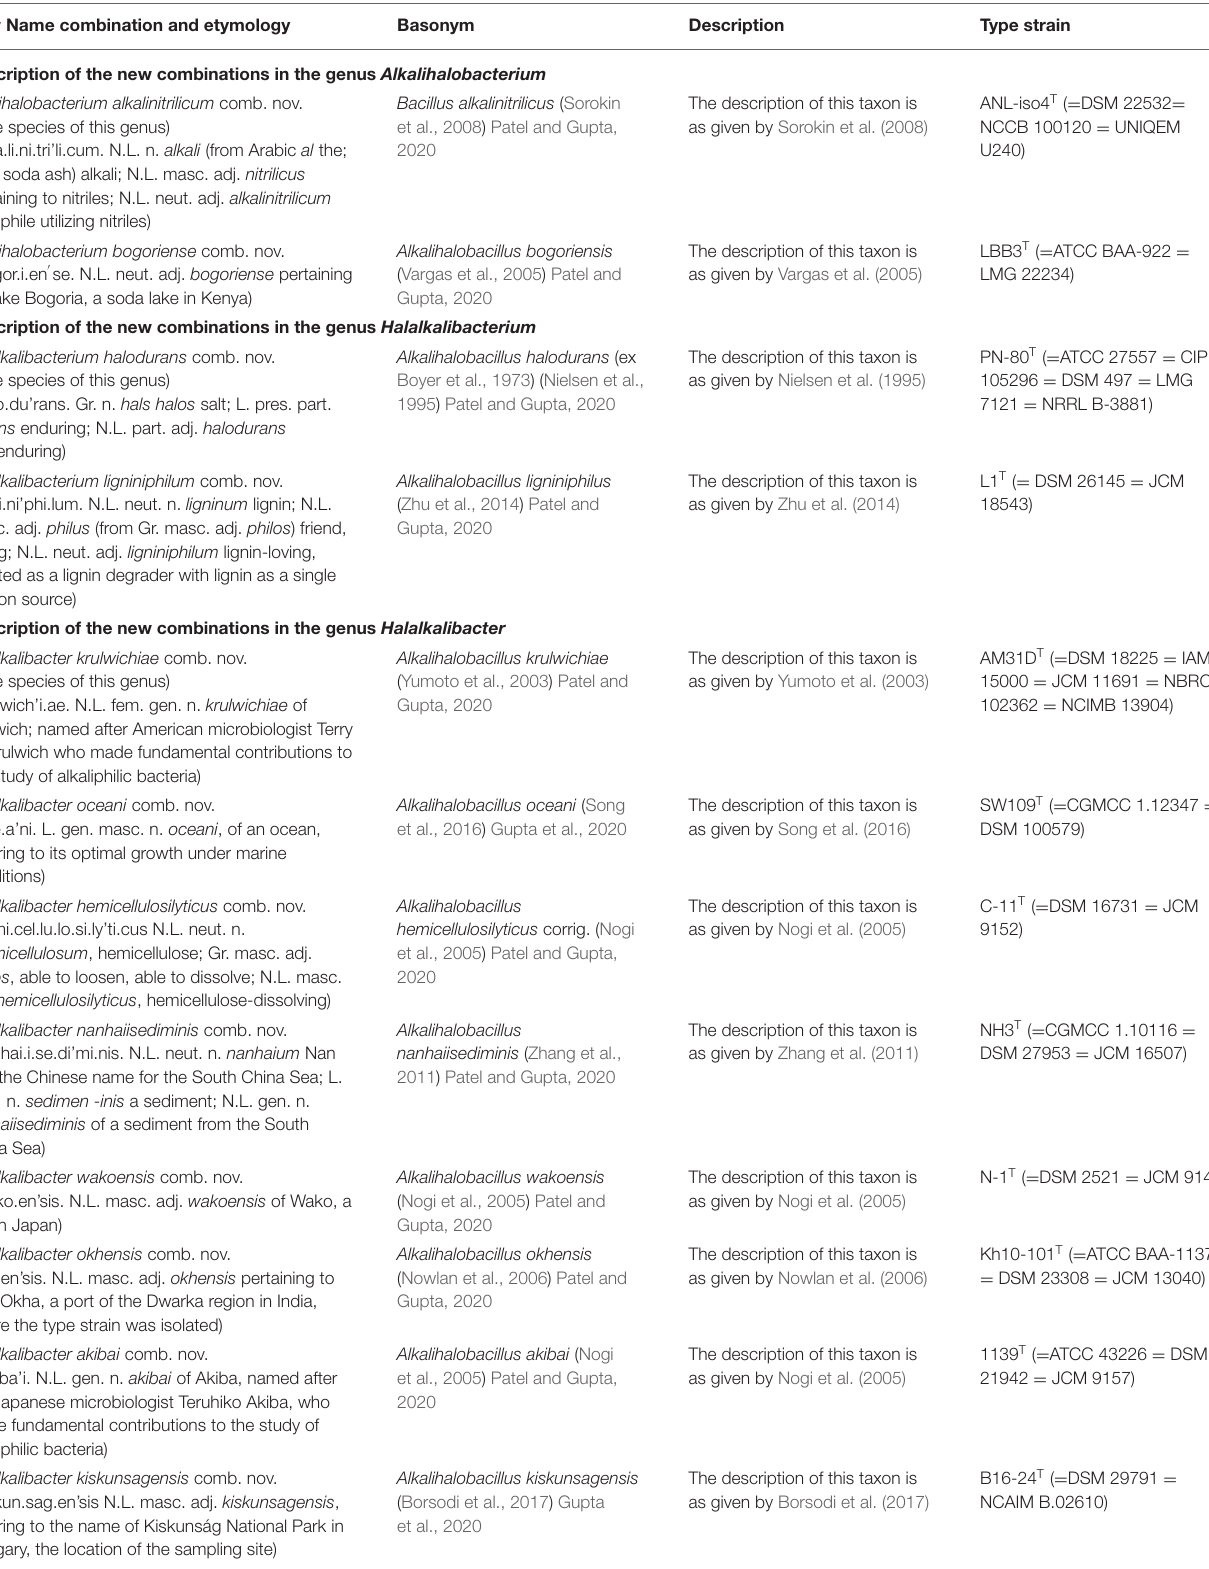
TABLE 5 | Description of the new combinations in the newly proposed